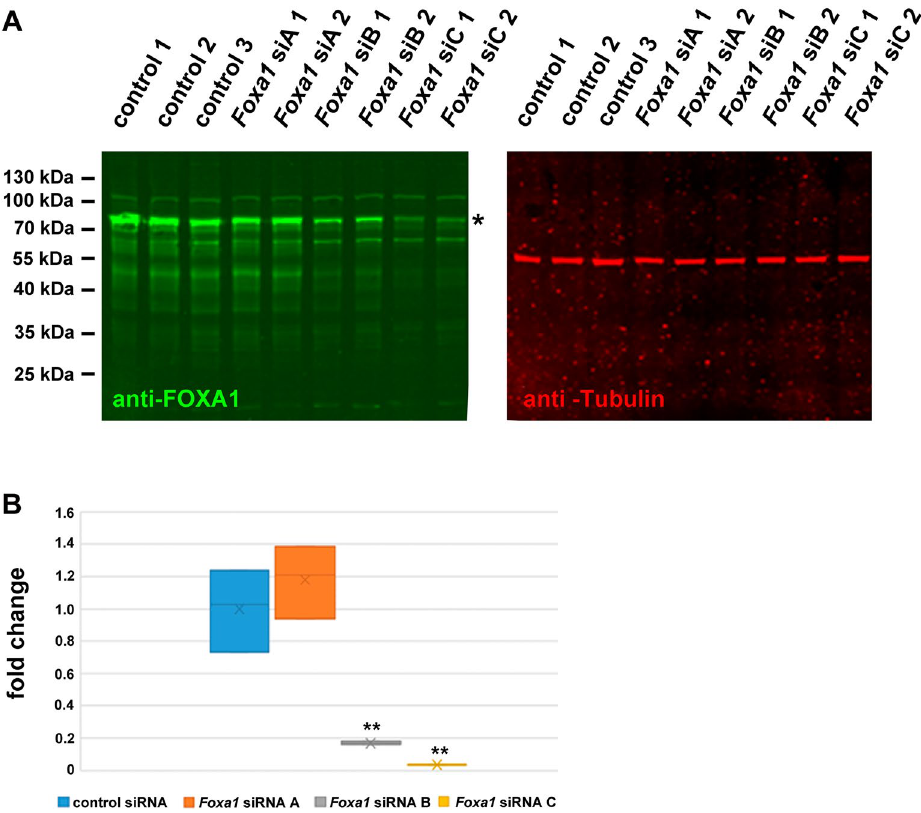
Figure 6. Knockdown of FOXA1::GFP by Foxa1 siRNA duplexes. ( A ) Western blots demonstrating the reduction in FOXA1::GFP by Foxa1 siRNA. Foxa1::gfp was co-transfected with either control siRNA (control) or one of the Foxa1 siRNA duplexes A, B, or C ( Foxa1 siA, B, or C). 48 h post-transfection cells were harvested, and the cell lysates were analysed by Western blotting. Detection of FOXA1::GFP (green, ~ 77 kDa, asterisk) and α-Tubulin (red) on the same blot. The original blots are presented in Supplementary Figure S2. ( B ) Efficient reduction of FOXA1::GFP by Foxa1 siRNA-mediated knockdown. The quantity of FOXA1::GFP was related to the quantity of α-Tubulin in the same lane and the fold changes in the relative quantities calculated to the average of the relative quantity in control siRNA transfected cells. Three biological replicates for each RNA duplex. Student’s T-test two-tailed, homoscedastic: siRNA A p = 0.412464, siRNA B p = 0.004772**, siRNA C p =